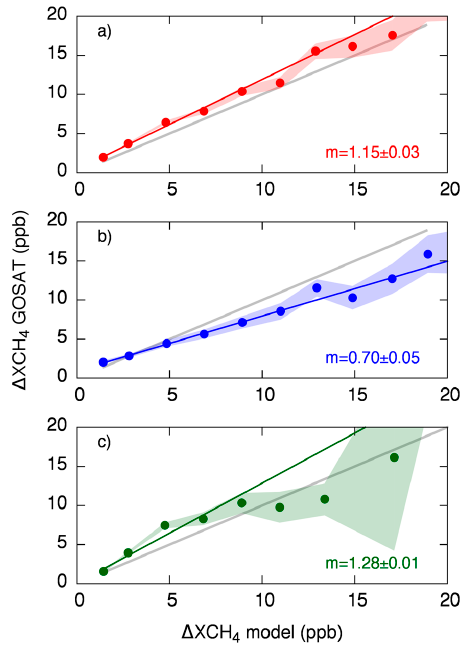
Figure 2. The regression between modeled (EDGAR, x -axis) and observed (GOSAT, y -axis) XCH 4 abundance for: ( a ) the Globe; ( b ) East Asia; and ( c ) North America. The inset values (m) are the regression coefficient (unit less) with the associated estimation error. The light shading represents the standard error in each bin. The colored lines show the regression model and the grey lines show the identity line. Table 1. List of high XCH 4 anomalies (>10 ppb) simulated ( Δ XCH 4,sim ) and derived from GOSAT observations ( Δ XCH 4,obs ) over different regions over the globe averaged over 2° grid cells. The central latitude and longitude are given.